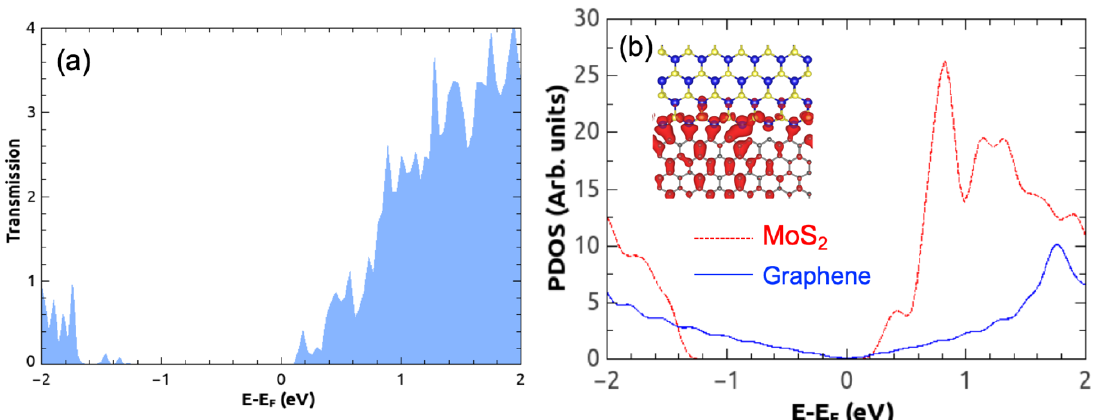
Figure 6. ( a ) Computed transmission spectrum (at zero bias) of a graphene/MoS 2 lateral heterostructure with Mo-terminated zigzag edge contacts (model 3 in Figure 5). The Fermi level corresponds to the reference (zero) energy. ( b ) Partial electronic density of states (PDOS) of graphene and MoS 2 . The inset shows the isosurface charge density (0.01 e/Å 3 ) near the Fermi level. Adapted from Reference [59].